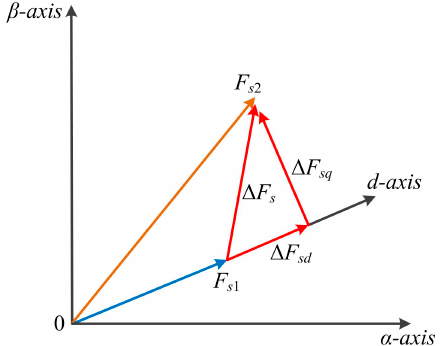
Figure 2. Errors of torque and flux in the d-q reference frame.